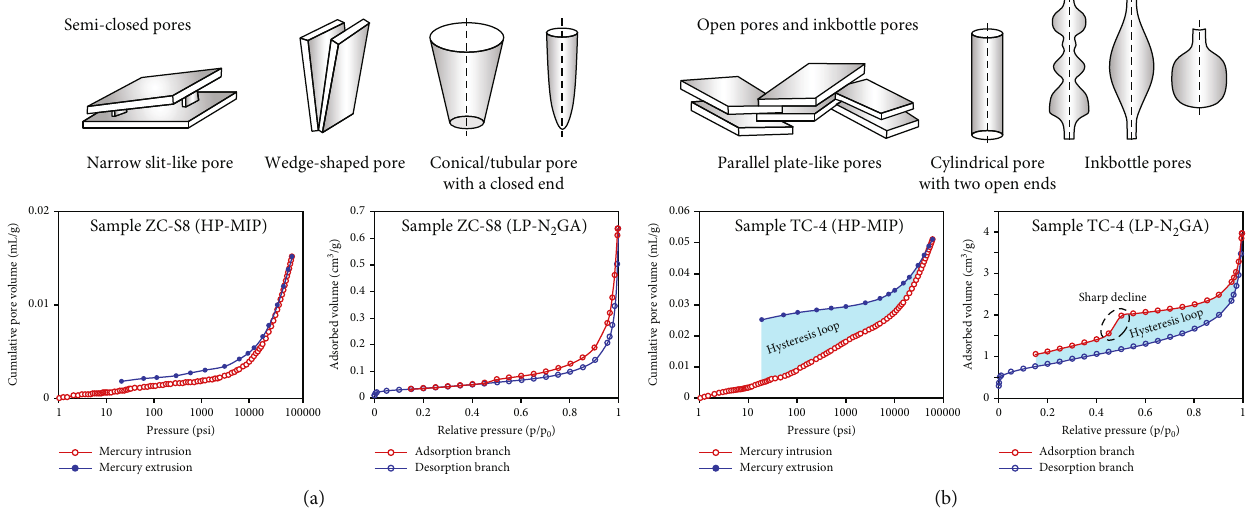
Figure 14: Schematic diagram of pore shape for the nonoutburst coal (a) and outburst coal (b) based on the HP-MIP and LP-N